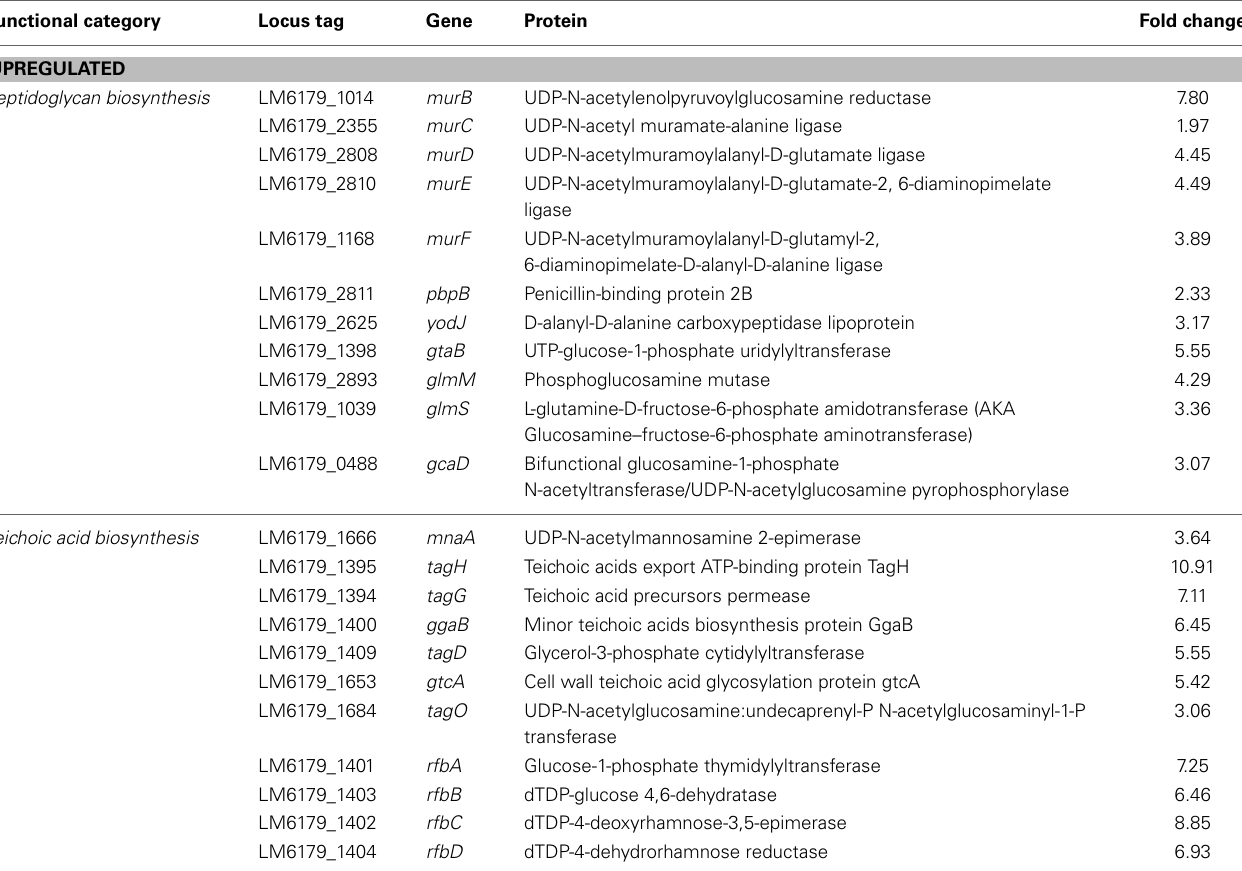
Table 5 | Peptidoglycan and teichoic acid biosynthesis genes which change in regulation following exposure of strain 6179 to BZT. Functional category Locus tag Gene Protein Fold